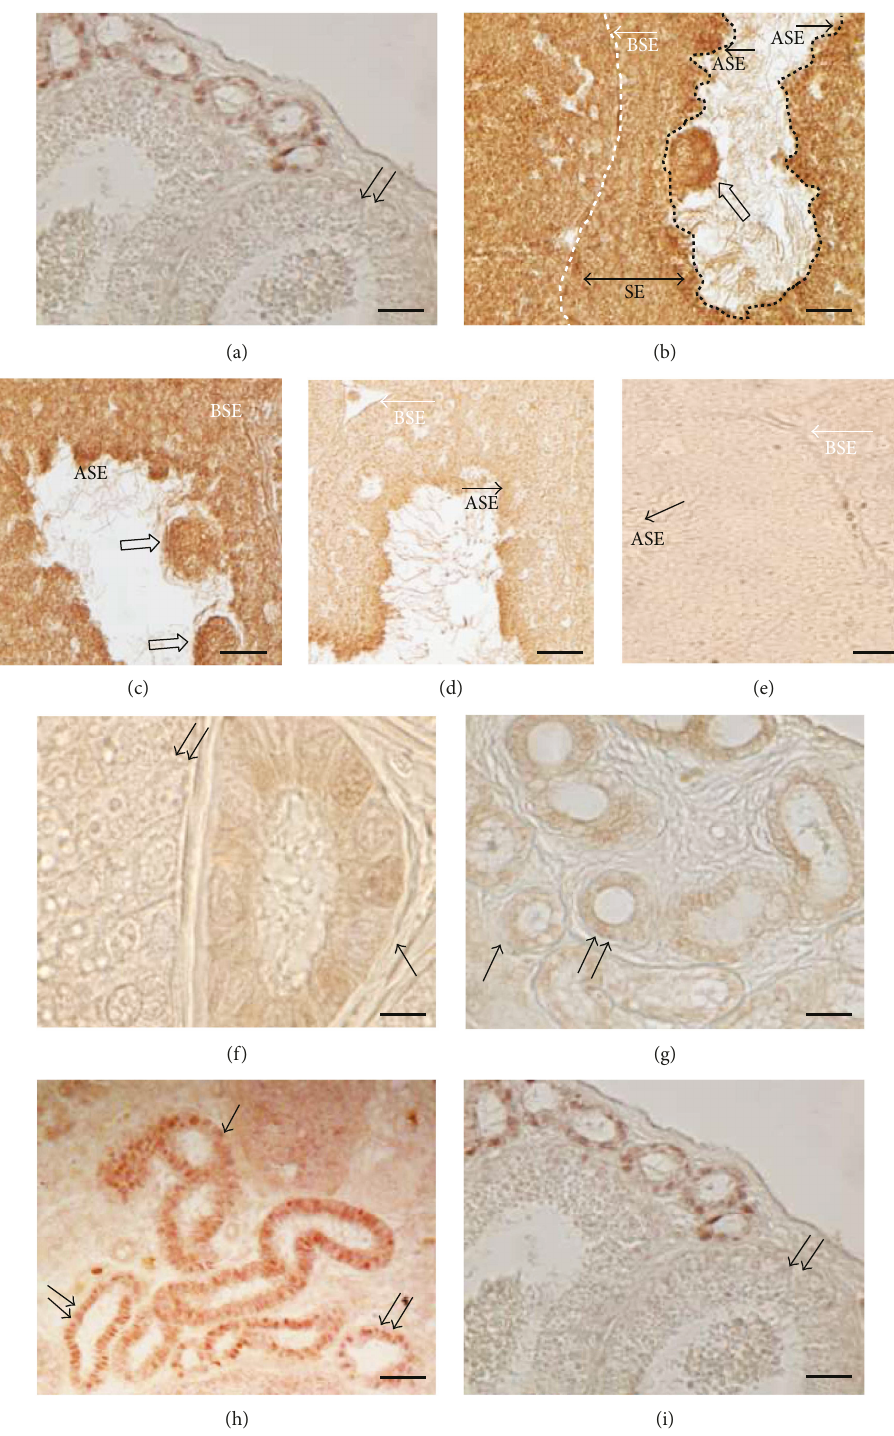
Figure 3: Immunohistochemistry with ER α antibody on the testis (a – e) and epididymis (f – i). (a) Untreated males: ir-ER α is evident only in the fi nal di ff erentiating stage, that is, spermatozoa. (b) Clomiphene-treated and (c) FSH-treated samples: ir-ER α is present in all the cells inside the seminiferous epithelium (SE). The dotted white and black lines indicate the basal (BSE) and apical (ASE) seminiferous epithelium, respectively. Note in (b, c), oocyte-like structure marked for ER α ( ⇧ ). (d) FSH-Clomiphene-treated samples: ir-ER α is evident only in spermatozoa. (f) Untreated males: ir-ER α is absent in the corpus ( ↑↑ ) but present in the e ff erent ductules ( ↑ ). (g) Clomiphene-treated and (h) FSH-treated samples: ir-ER α is evident in the cells lining the corpus ( ↑↑ ) and in the e ff erent ductules ( ↑ ). (i) FSH-Clomiphene-treated samples: ir-ER α is absent in the corpus ( ↑↑ ). (e) Negative control prepared omitting the antibody in the reaction. The bar is 30 μ